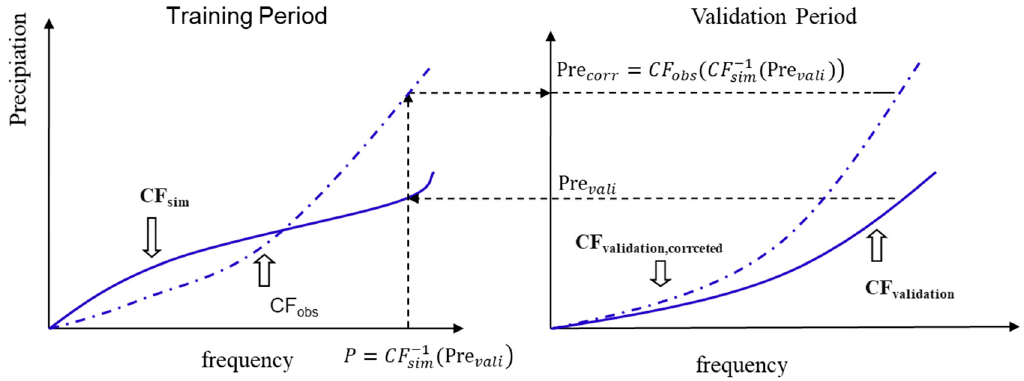
Figure 3. Illustration of the quantile mapping method.